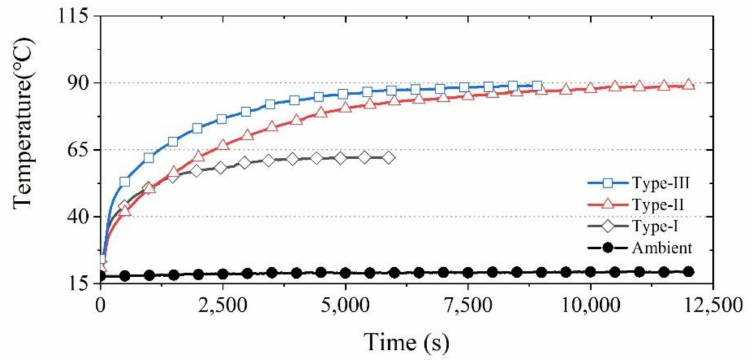
Figure 15. Thermal performance test result: Motor winding temperature.